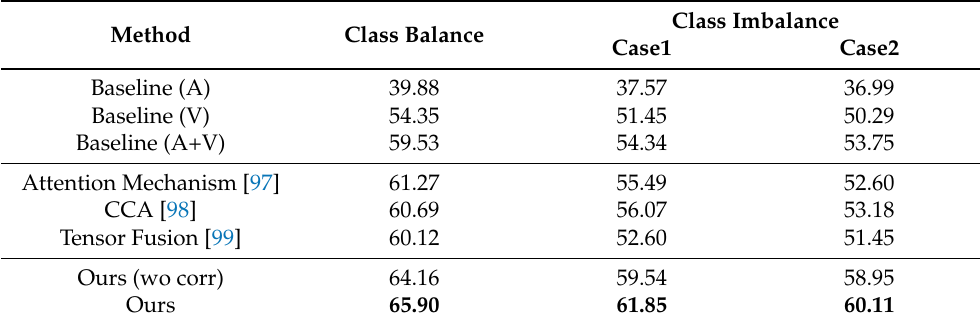
Table 8. Classification accuracy (%) of different methods when the training set is class-imbalanced on the RAVDESS dataset. Best results are shown in bold.